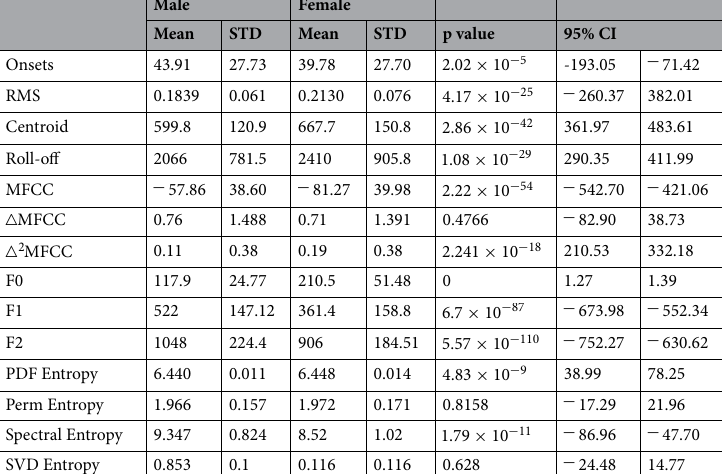
Table 4. Voice fundamental metrics results of gender